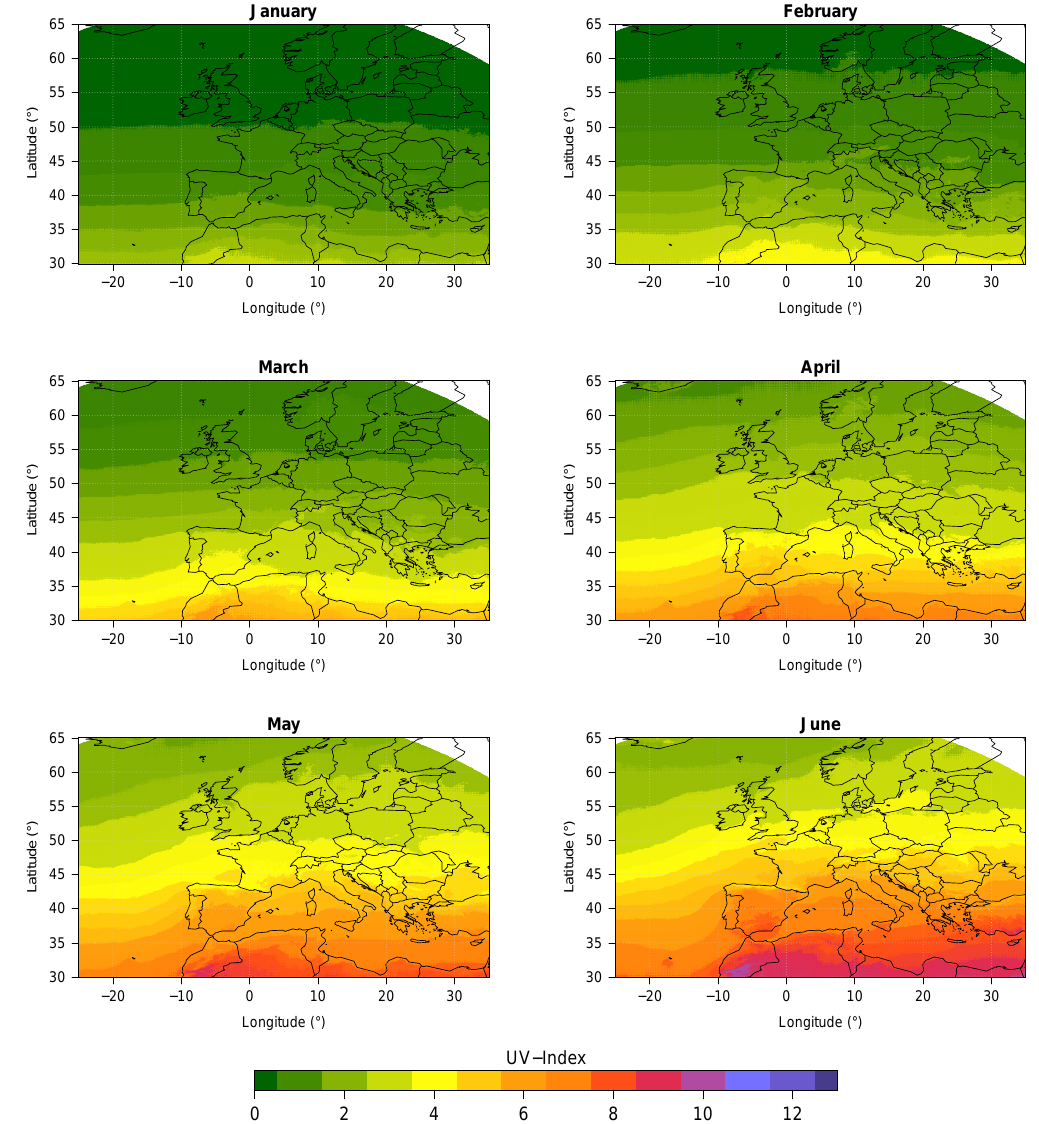
Figure 3. Monthly mean UVI at the local noon over Europe for January until June over the time period 1983–2015 based on satellite